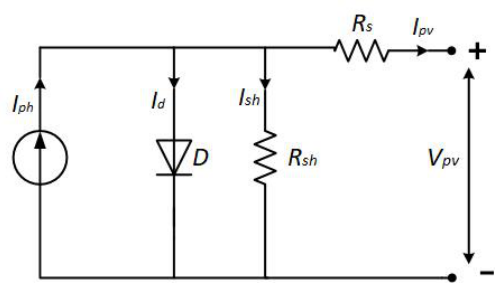
Figure 2. Single diode model of PV